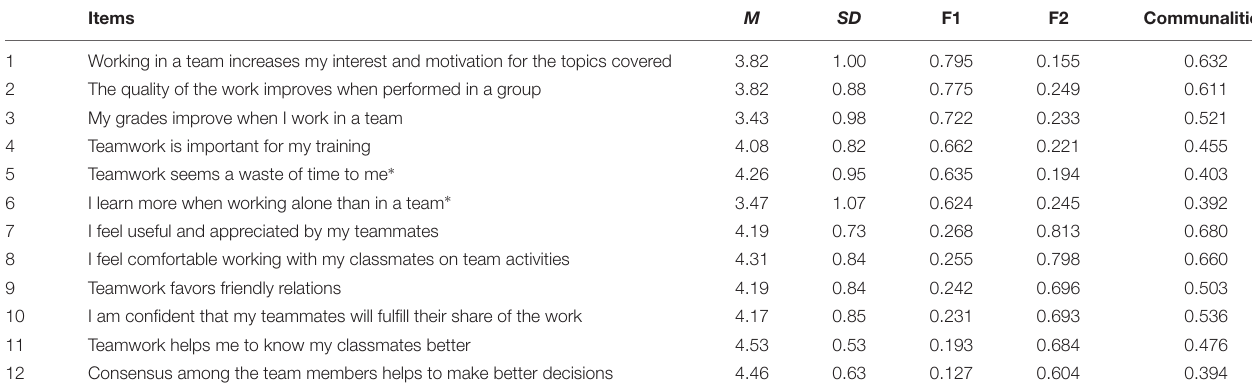
TABLE 1 | Exploratory Factor Analysis of the Questionnaire of Attitudes toward Learning Teams (CACTE). Items